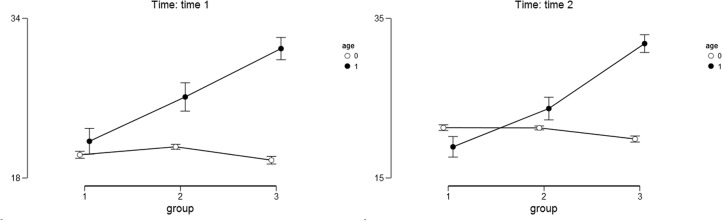
Descriptive statistics for positive affect as the outcome variable. Age – 0 stands for younger children and 1 stands for older children. Group – 1 stands for control group; 2 stands for placebo group; 3 stands for narrative group. Error bars represent the 95% CI of a mean.